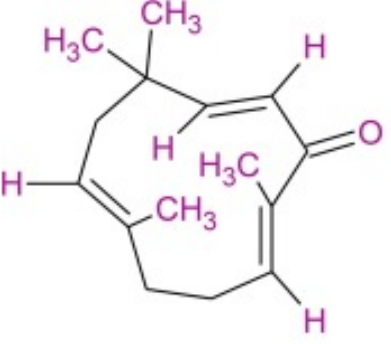
Figure 1. Chemical structure of zerumbone